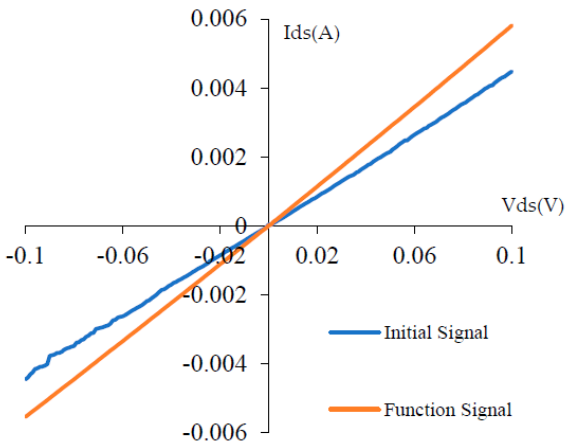
Figure 8. I − V curves corresponding to the initial signal, and the signal after thiolation, AChE func- AChE tionalization.